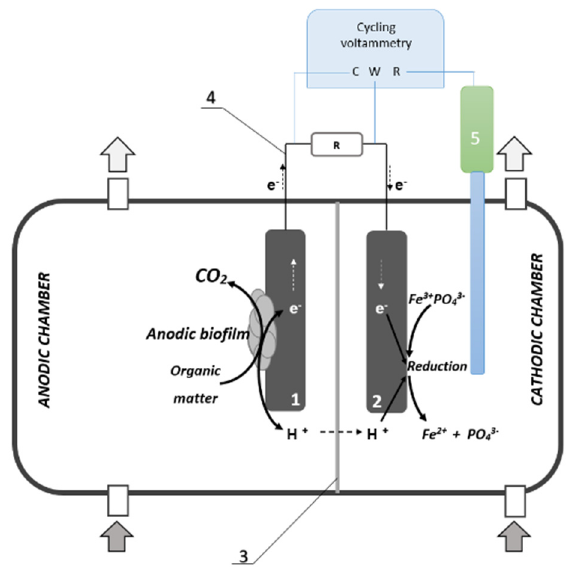
Figure 5. MFC reactor configuration and experimental design used during the phosphate recovery; 1—anode, 2—cathode, 3—PEM, 4—external circuit and resistor, 5—reference